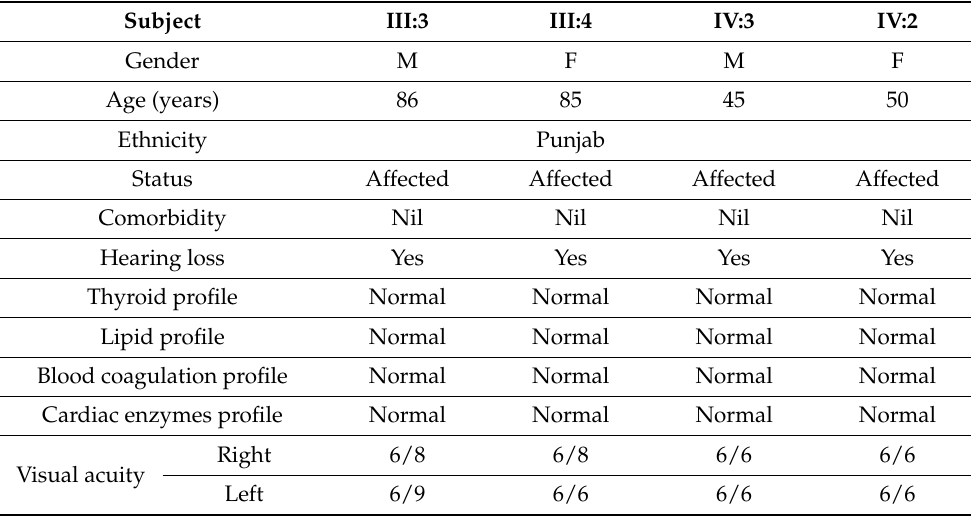
Table 1. Clinical evaluation of four members of GCUFAHL38